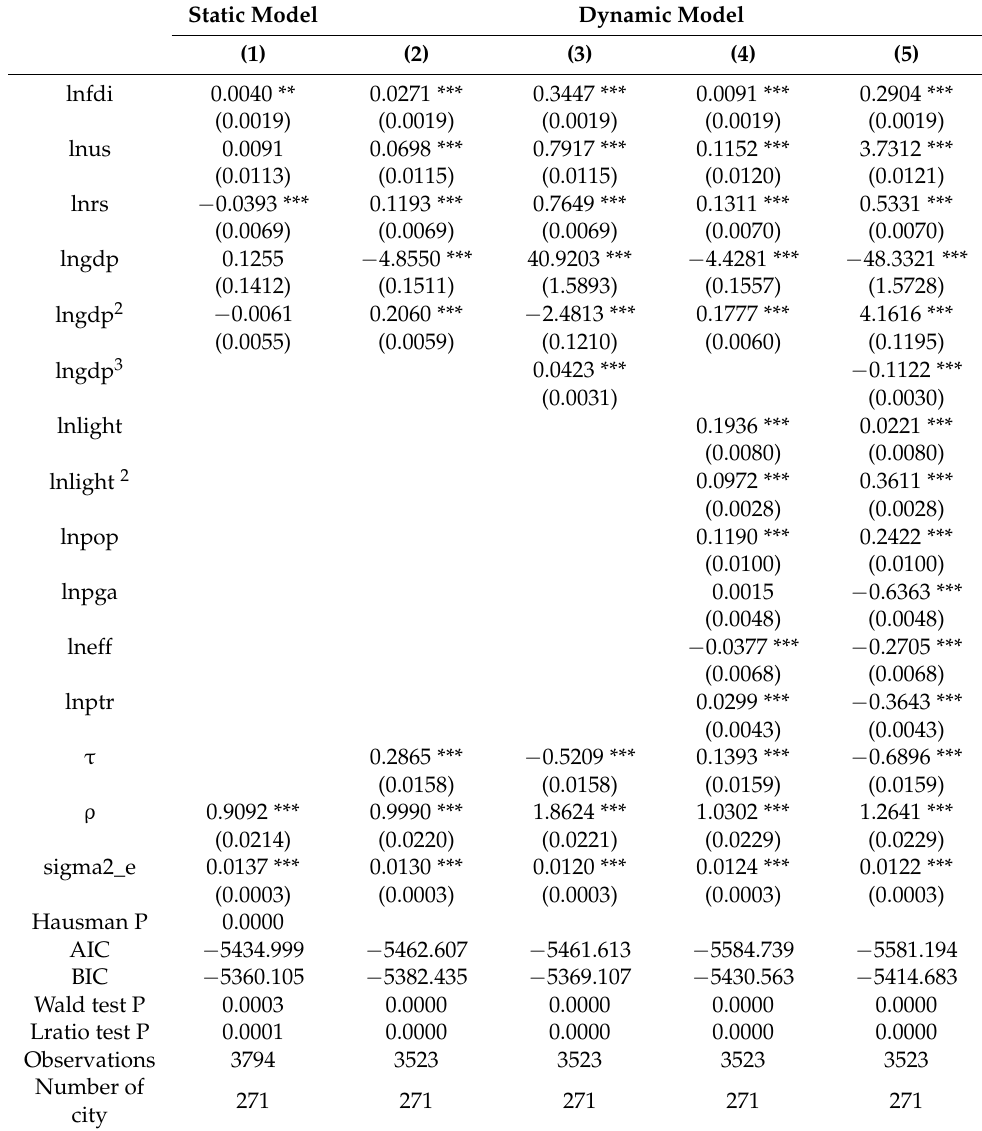
Table 5. Empirical results regarding the PHH based on PM 2.5